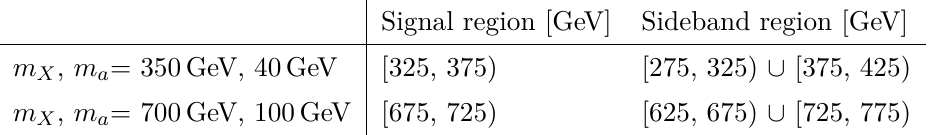
Table 1. Table of selections on √ Truth ˆ s